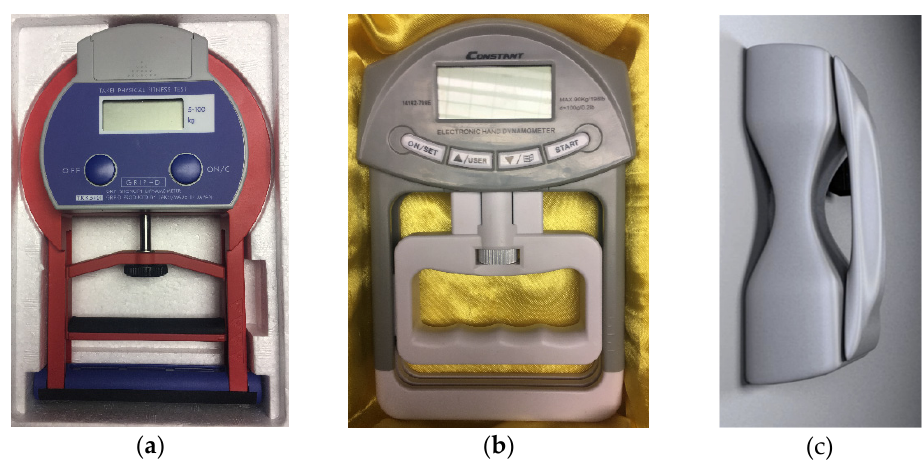
Figure 11. ( a ) Takei 5101 TKK, ( b ) Constant 14192-709E, ( c ) hand grip device UIB.